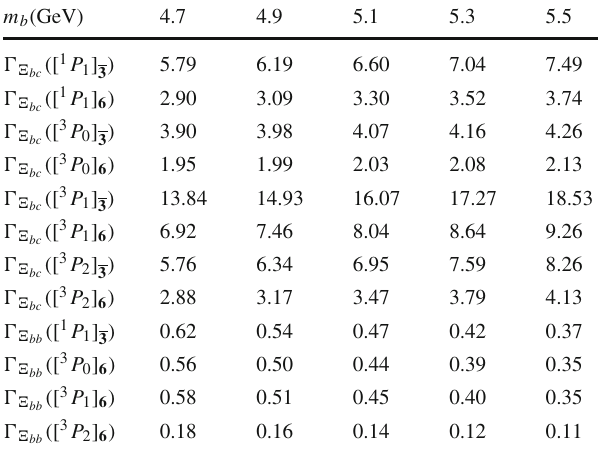
Table 4 Theoretical uncertainties for the production of P -wave (cid:2) cc and (cid:2) are 10 − 9 GeV